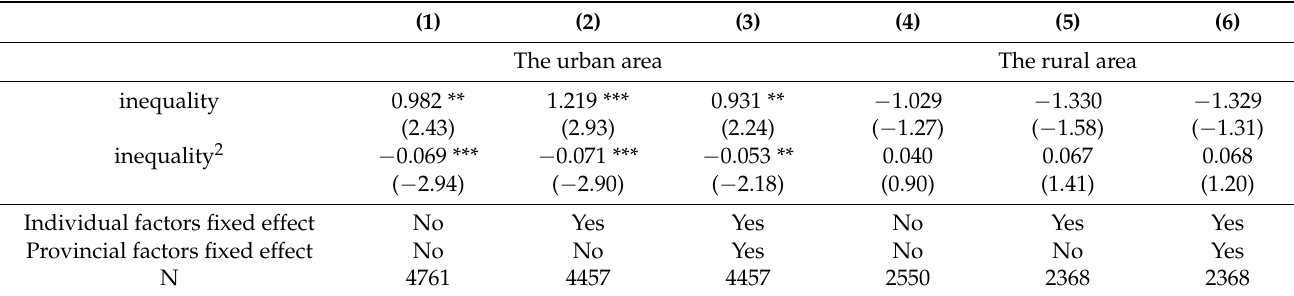
Table 7. The effect of individual-level income inequality on subjective environmental pollution: differences in the urban and rural